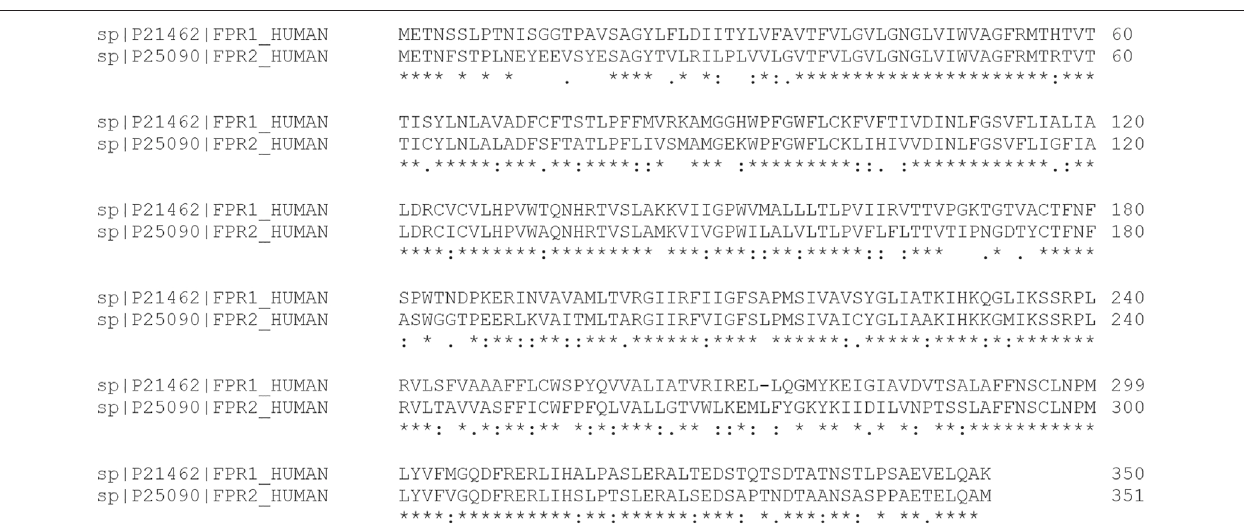
Frontiers in Cell and Developmental Biology |